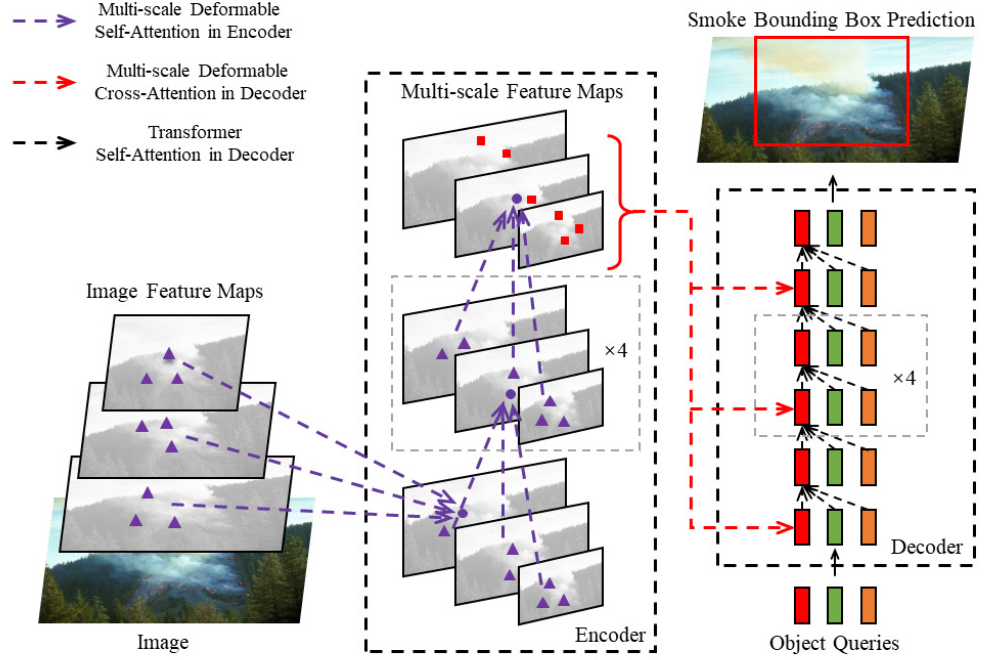
Figure 2. The network structure of deformable DETR.